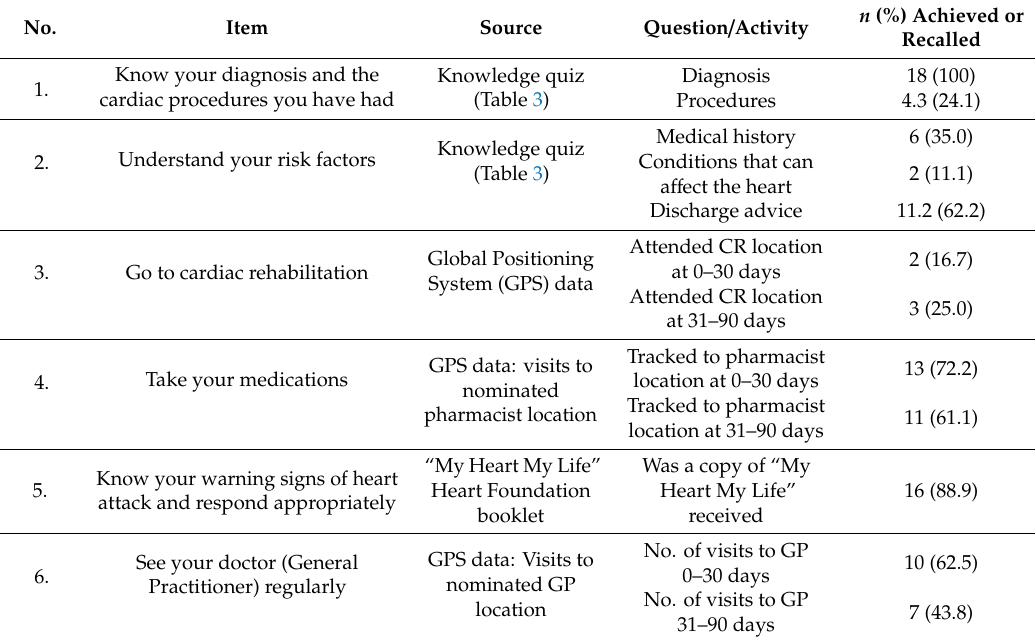
Table 5. Overall scorecards for adherence to discharge advice (6